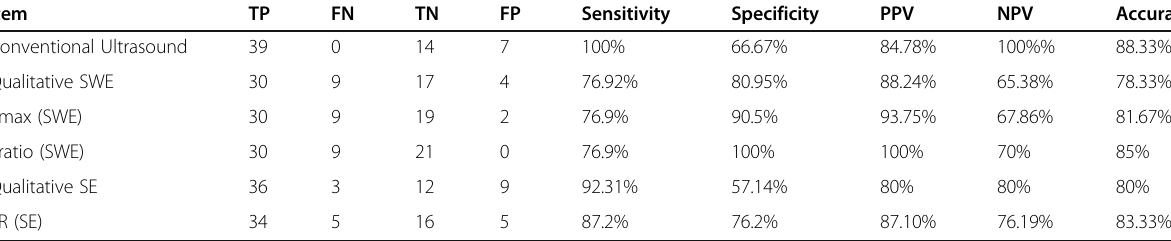
Table 5 Diagnostic indices of the different modalities used in the